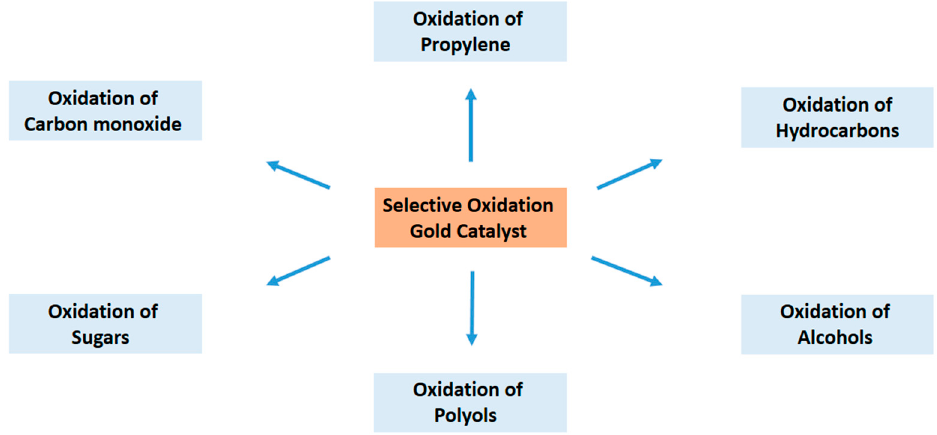
Figure 4. Some selected examples of the application of Au catalysts.